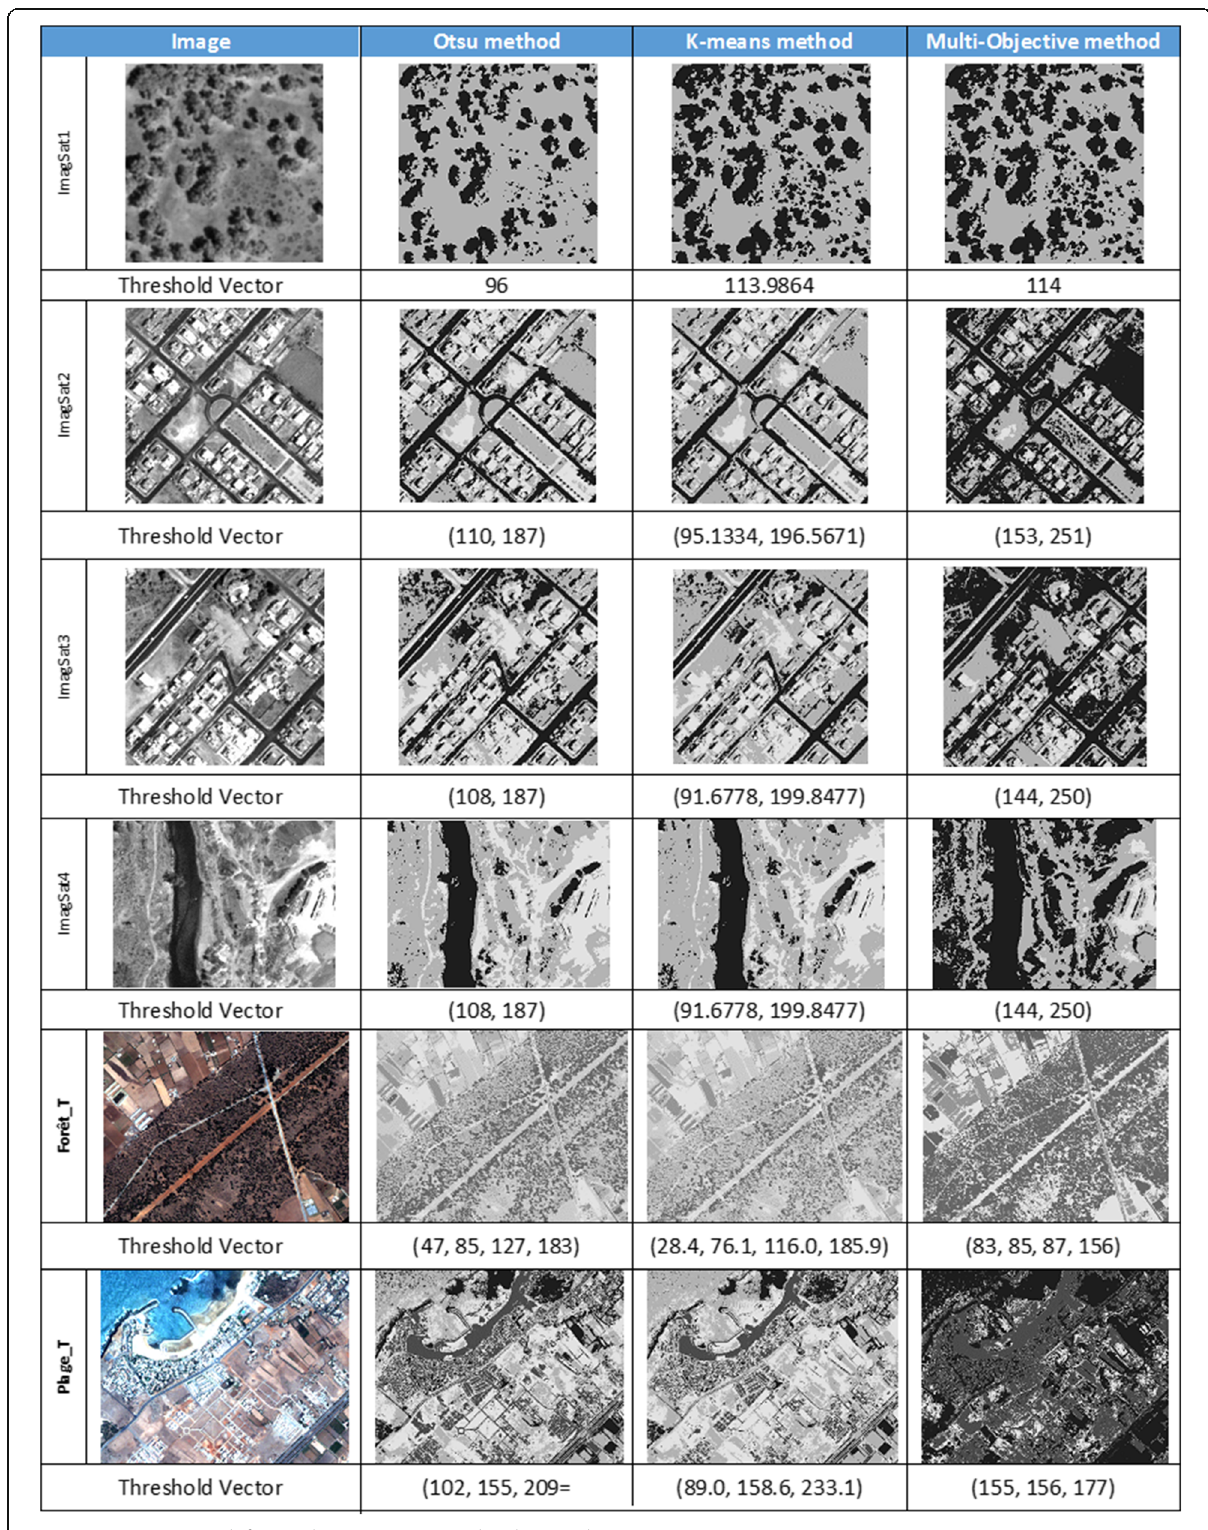
Fig. 5 Segmentation result for panchromatic images and multispectral